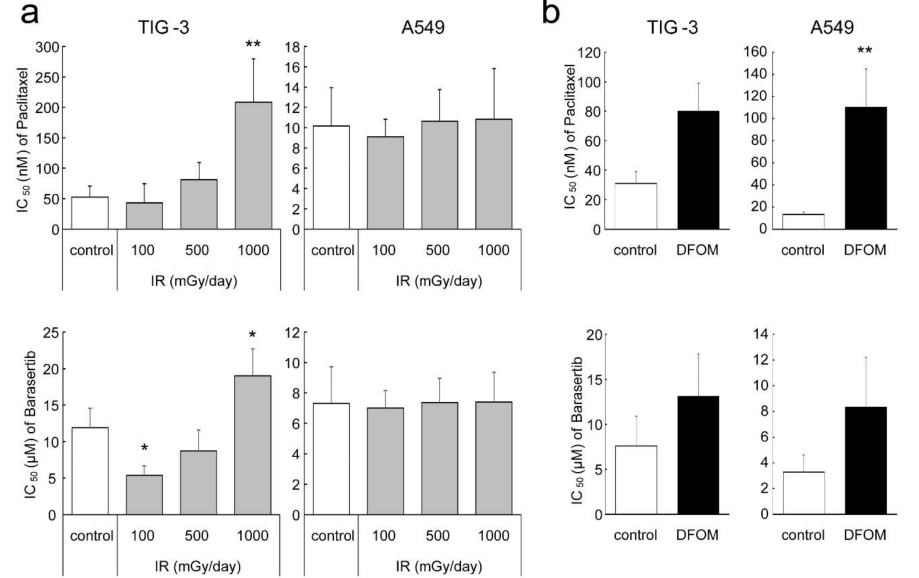
Figure 6. Effect of LDR-IR on sensitivity to cell cycle-targeting anti-cancer drugs. IC 50 values in response to paclitaxel and barasertib in TIG-3 and A549 cells pre-treated with LDR-IR ( n = 4) ( a ) or DFOM ( n = 5) ( b ) were evaluated with the MTT assay. ( a , b ) Values are means and SD. * p < 0.05 vs. control; ** p < 0.01 vs.